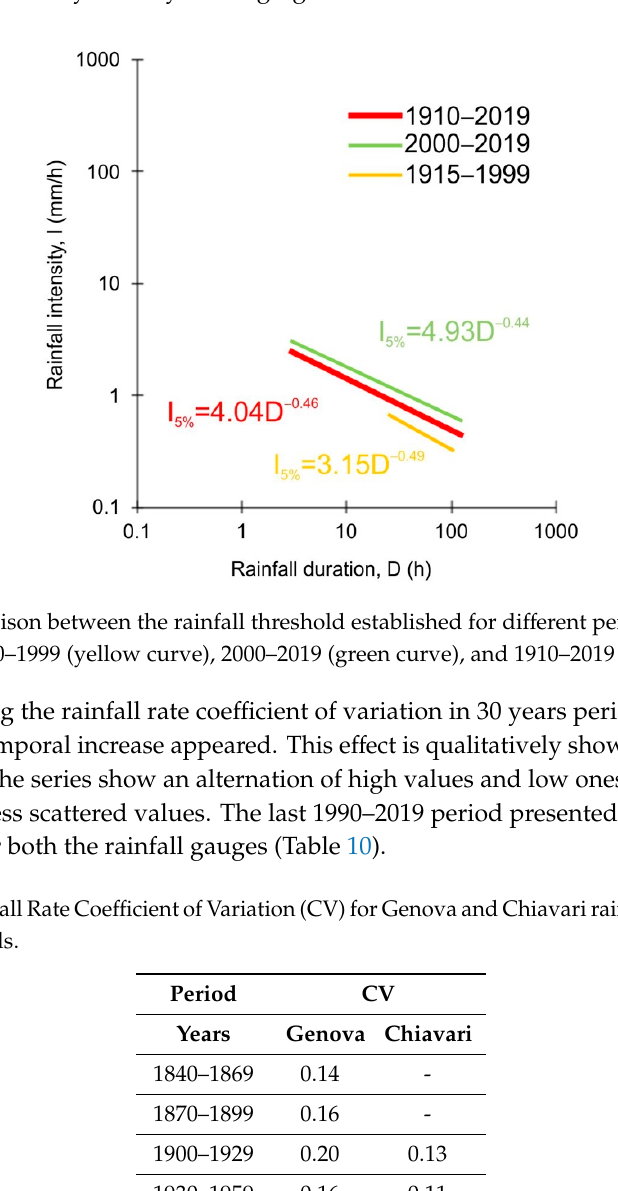
Figure 13. Maximum rainfall in 1 ( A ), 3 ( B ), 6 ( C ), 12 ( D ), and 24 ( E ) h in the yearly series of Chiavari